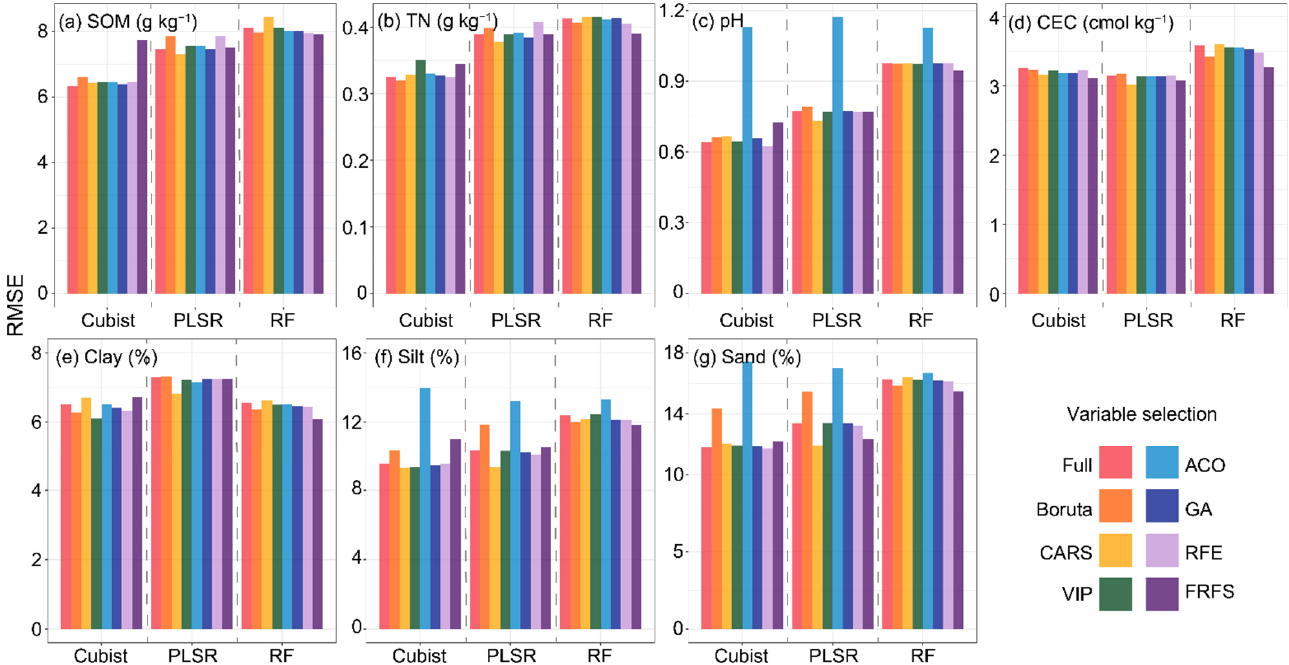
Figure 7. The model performance (RMSE) of three predictive algorithms and seven variable selec- tion algorithms. The full means the model built on the full spectra which would be useful for model comparison.